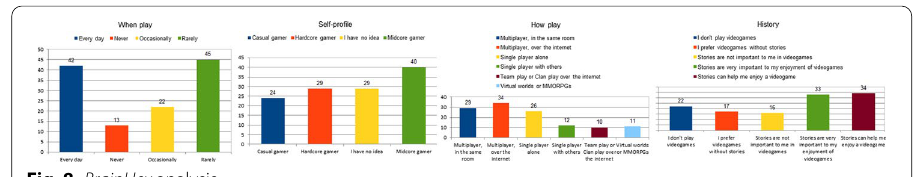
Fig. 8 BrainHex analysis